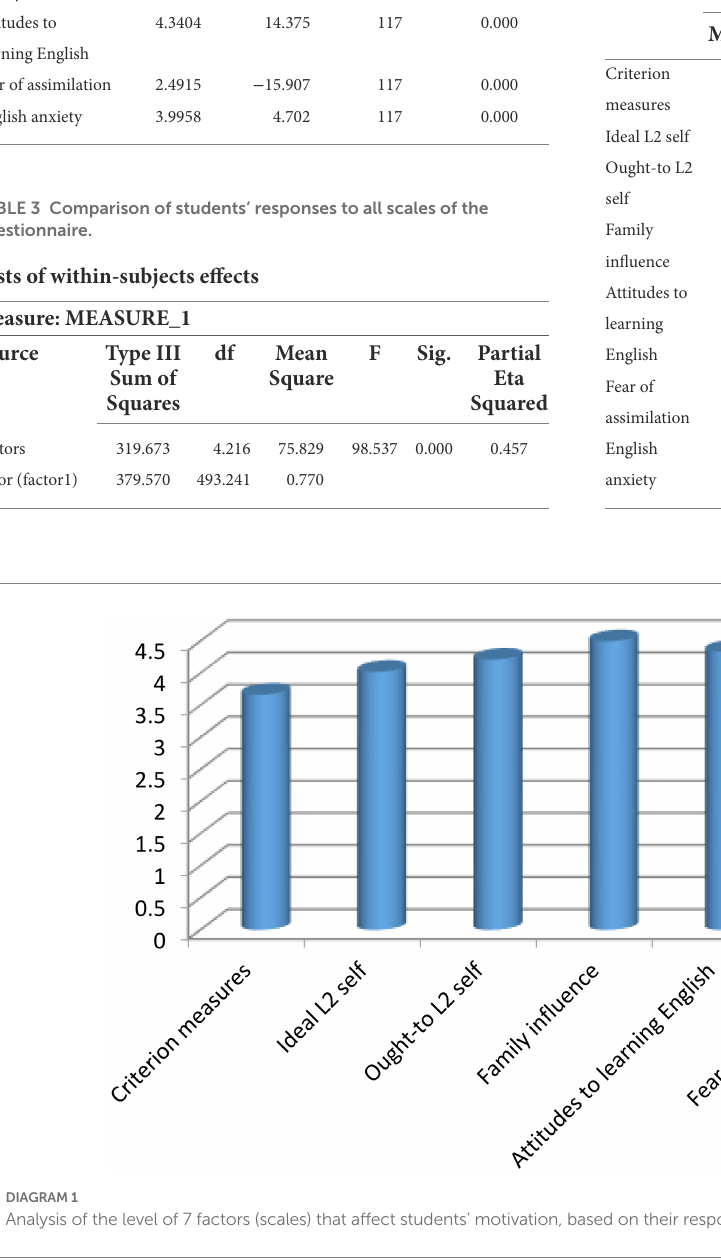
TABLE 4 Male vs. female participants’ distribution of responses to each of the 7 categories of the questionnaire. Name of